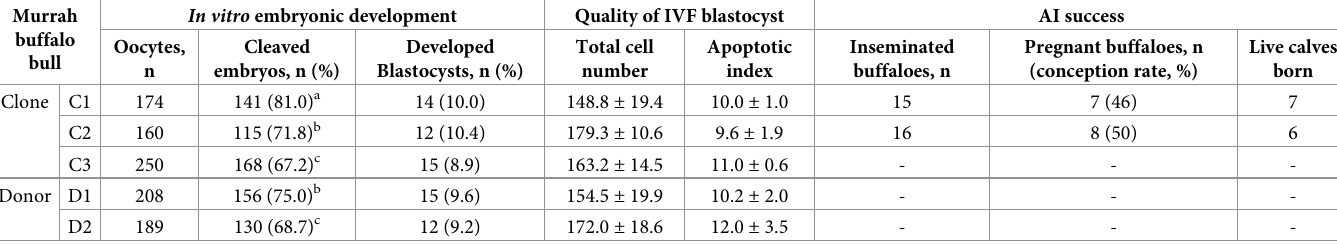
Table 3. In Vitro Fertilization (IVF) and Artificial Insemination (AI) using frozen-thawed semen of cloned bulls and donors. Murrah buffalo